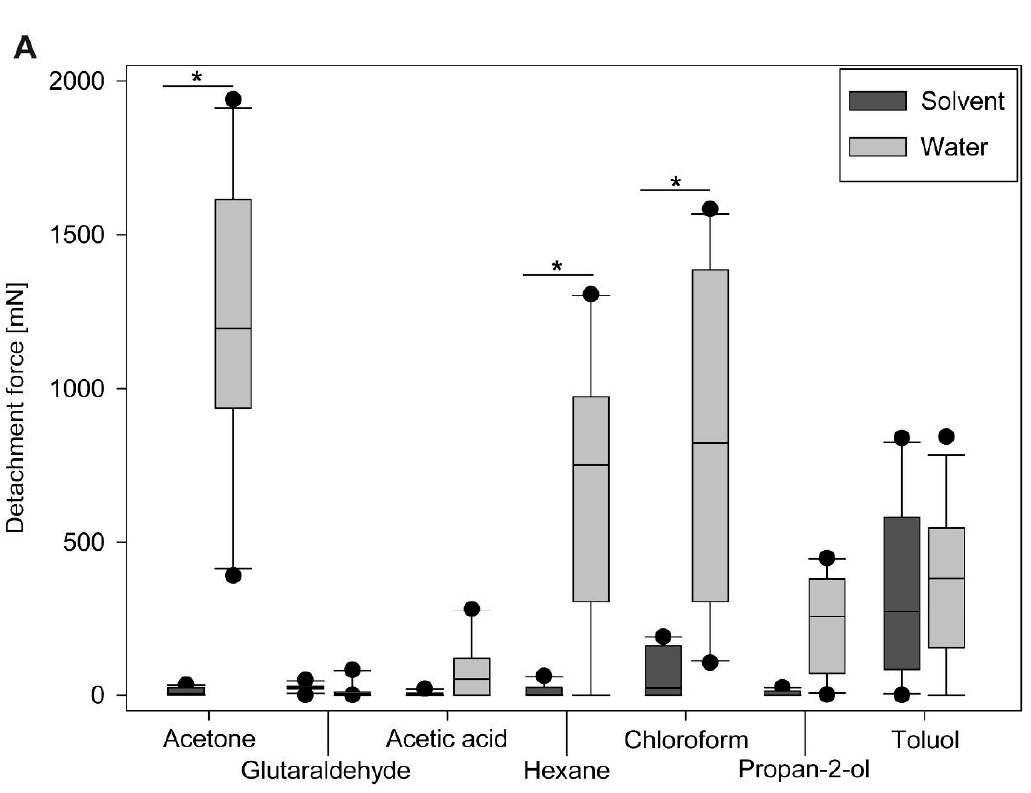
Figure 8. Maximum detachment forces of eggs for all solvents and their corresponding maximum detachment force of the water treatment during the cross-treatment experiments: ( A ) Boxplots for all solvents and the water treatment. The cycle with the highest median detachment force has been picked for each treatment. Statistical difference is shown only between the solvent and the corresponding water treatment (Kruskal–Wallis ANOVA on ranks, p ≤ 0.001). *= p < 0.05 (Dunn’s post hoc test). Differences between the solvents, or the water treatments, respectively, are shown in B and C; ( B ) Comparison of maximum detachment forces for the solvents cycles of the sequential cross treatment experiments; ( C ) Comparison of maximum detachment forces for the water cycles of the sequential cross treatment experiments; The horizontal line represents the median, the upper and lower borders of the boxes represent 25 and 75 percentiles and the whiskers represent 10 and 90 percentiles. Groups with the same lowercase letter are statistically not different (Kruskal–Wallis ANOVA on ranks, Dunn’s post hoc test, p < 0.05).